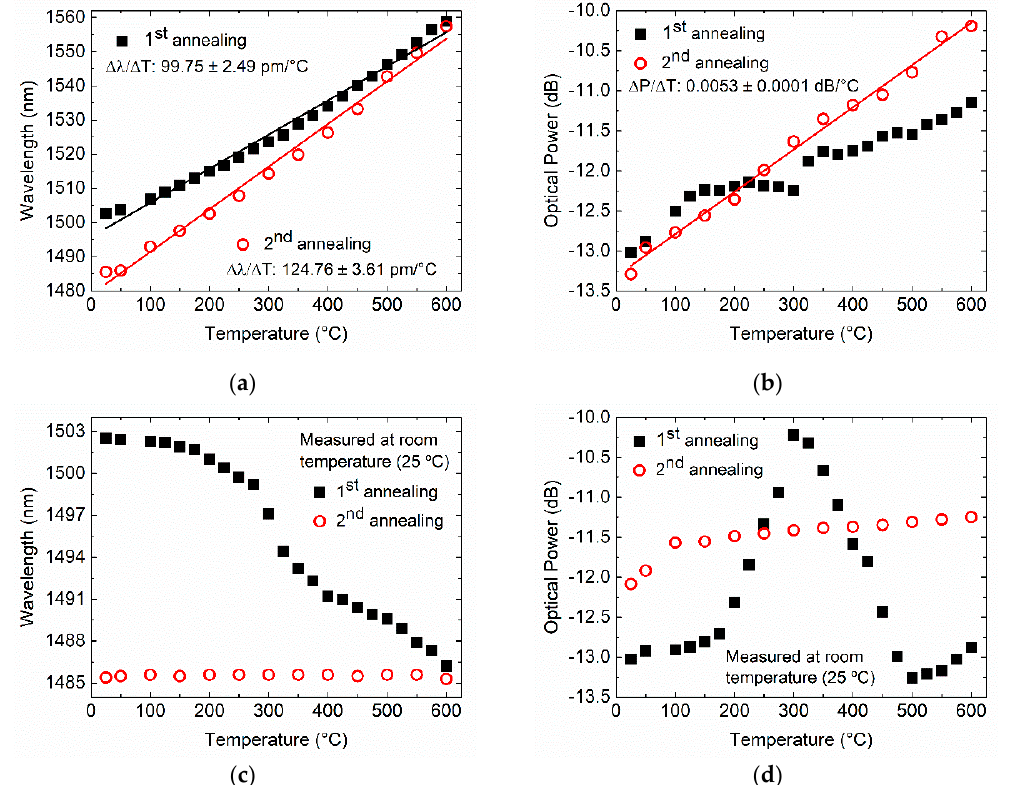
Figure 7. Fs-laser LPFG inscribed with a period of 372.5 µm: ( a ) wavelength shift, and ( b ) strength of the peak attenuation at the annealing temperature; ( c ) wavelength shift, and ( d ) strength of the peak attenuation, at room temperature.